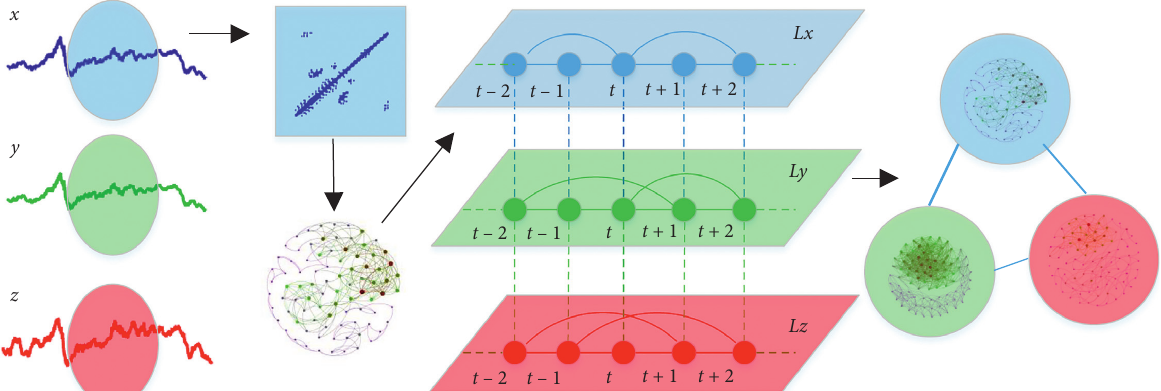
Figure 1: The multiplex recurrence network (MRN) algorithm maps a three-dimensional series into a three-layer multiplex recurrence network.